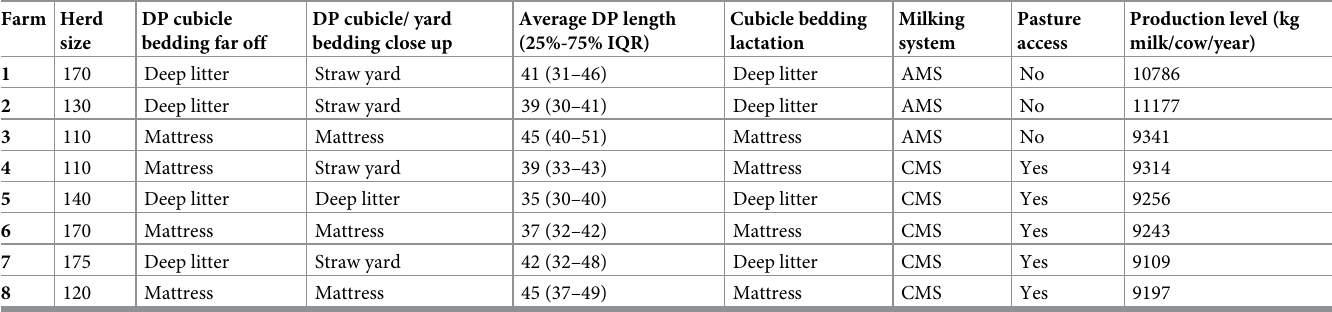
AMS = automatic milking system. CMS = conventional milking system. DP = dry period. IQR = interquartile range. Deep litter is related to cubicle systems where a straw yard means a free-range area. Pasture access is for lactating animals